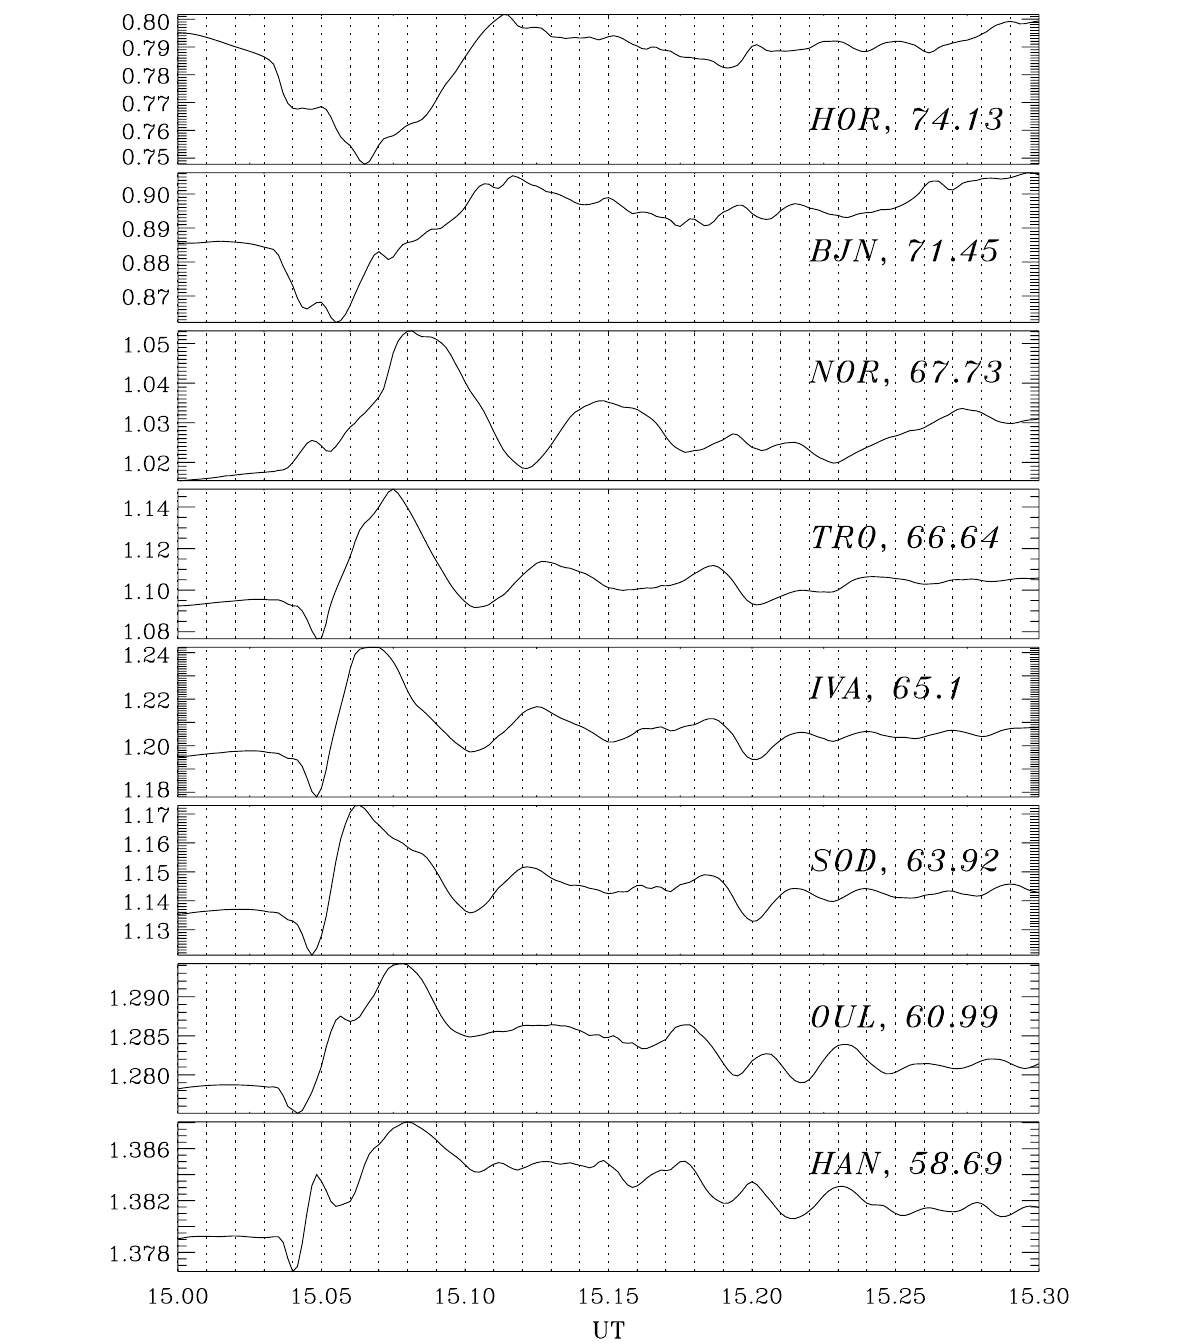
where ρ and V are the plasma density and velocity and B is the magnetic field vector. The indices 1 and 2 denote the medium parameter prior to (upstream) and after (downstream) a shock,